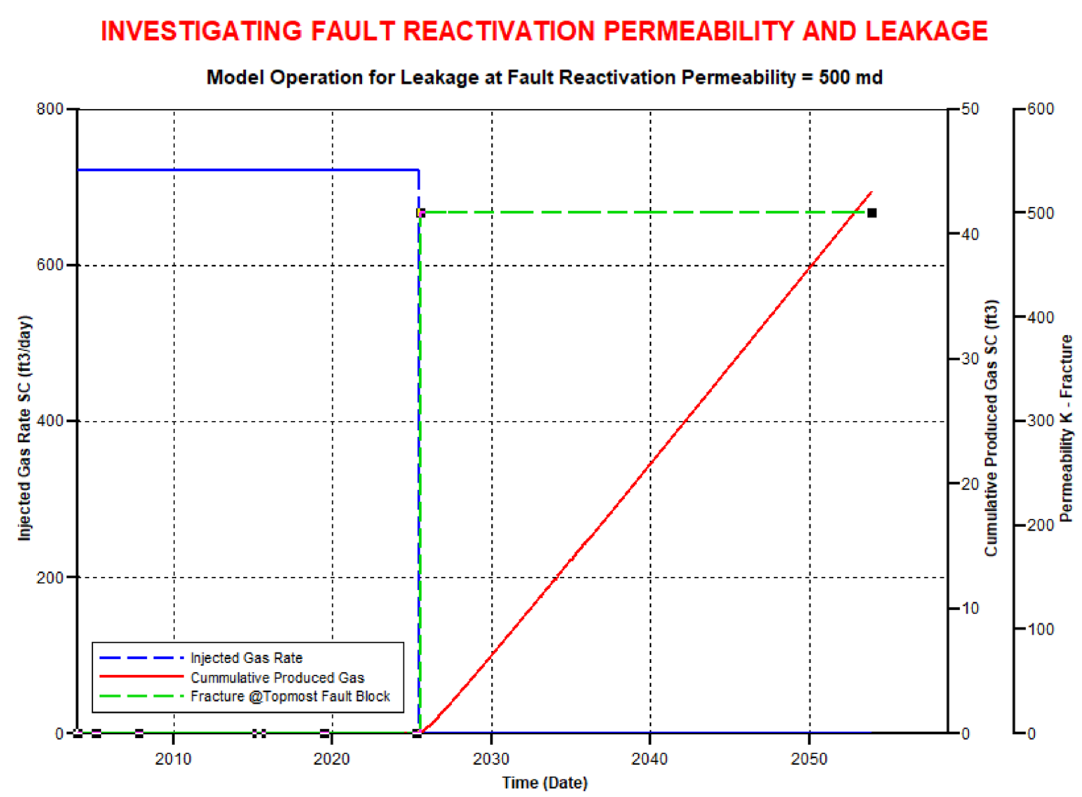
Fig. 20 Model operation for quantifying leakage of injected carbon dioxide at hydraulic fracture permeability of 500